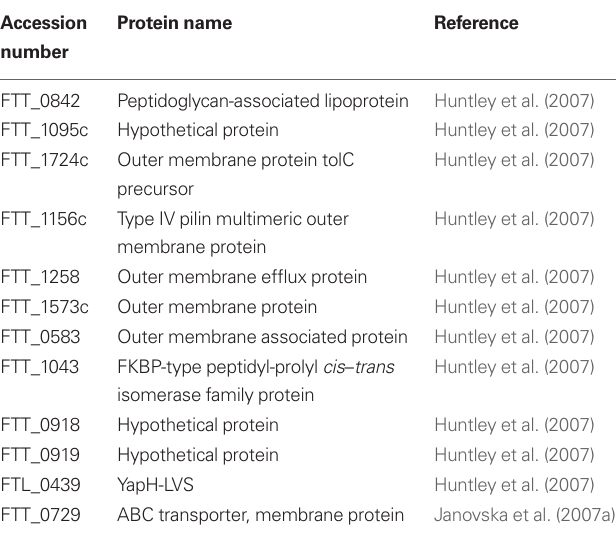
Table 2 | Francisella tularensis LVS outer membrane proteins, isolated using density gradient